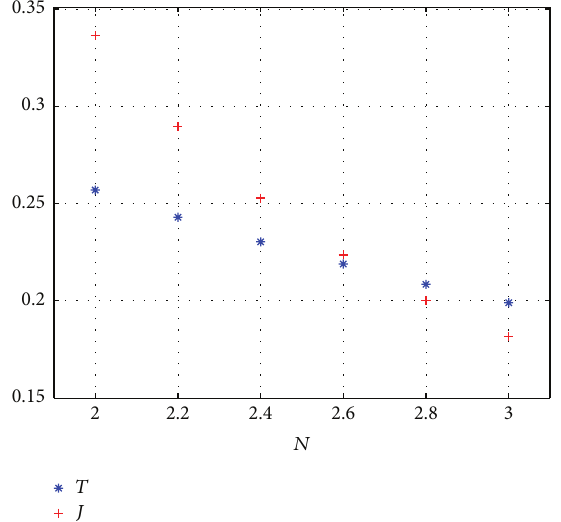
Figure 8: Diagram for transferring payment and social welfare versus average income with